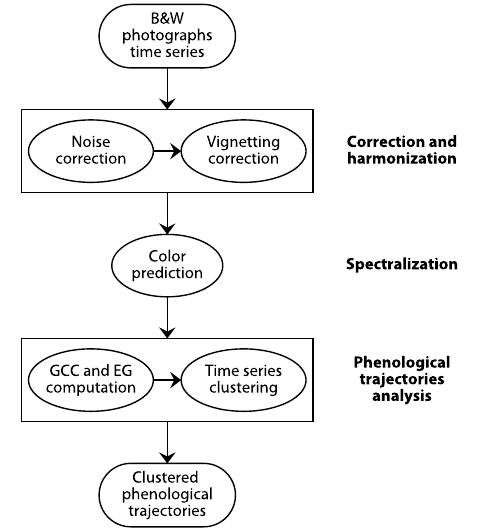
Figure 2. Proposed workflow for reconstructing